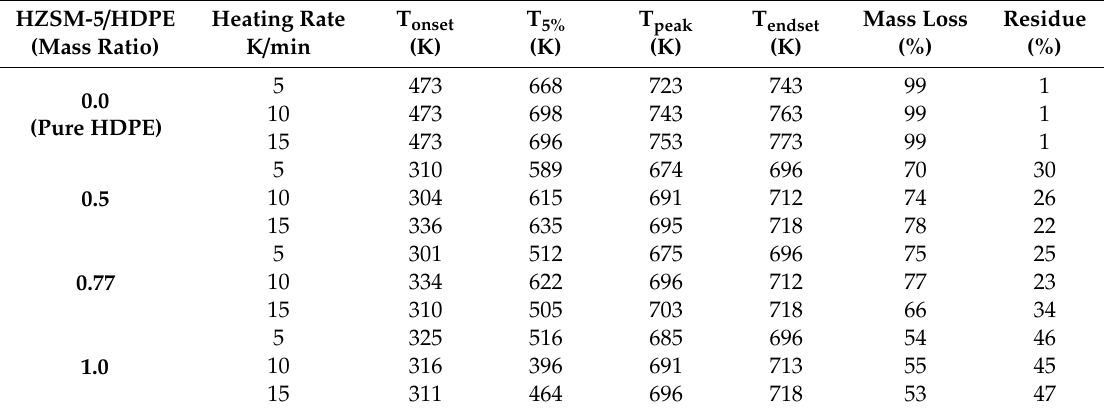
Table 5. Thermogravimetric analysis data.